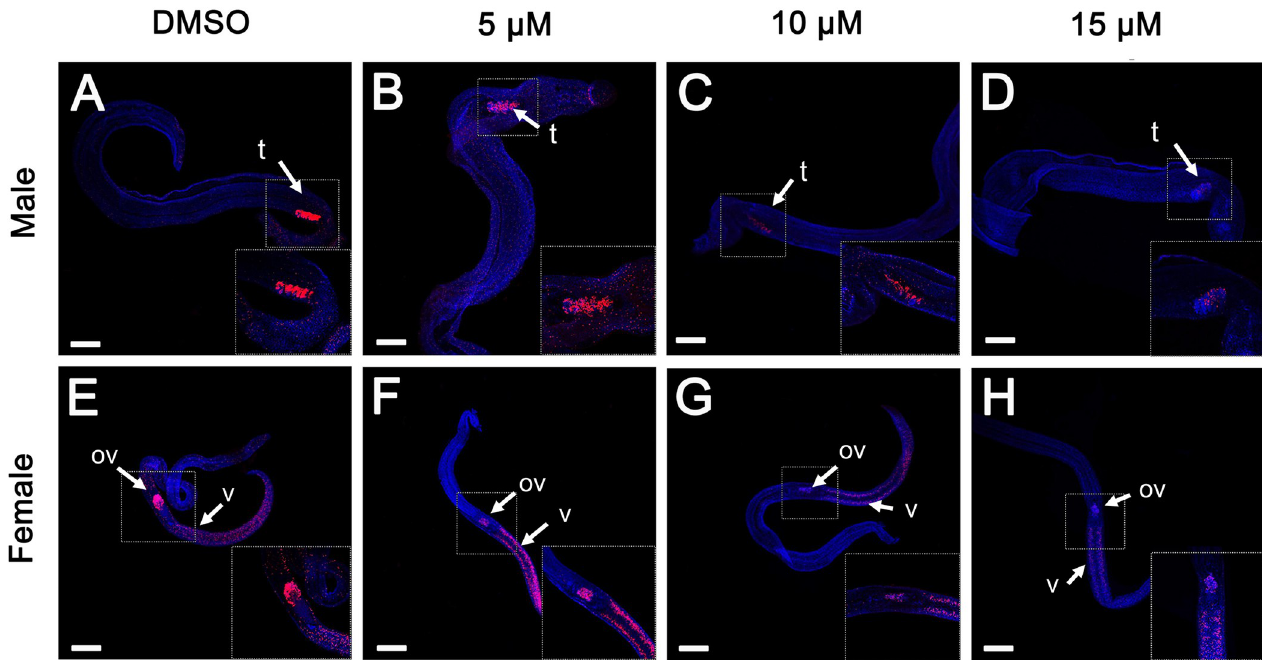
Fig 2. Effect of JQ-1 on cell proliferation in male-female pairs of S . japonicum . Red signals indicate active mitotic cells labeled by EdU; blue signals, Hoechst-positive cells. (A-D) Male S . japonicum and (E-H) female S . japonicum . EdU-incorporated cells are detected in the testes and parenchyma of untreated males (A) and in the vitellarium and ovary of untreated females (E). EdU-positive cells are detected after application of JQ-1 at 5 μ M (B, F), 10 μ M (C, G), and 15 μ M (D, H). Abbreviations: ov, ovary; t, testes; SV, seminal vesicles. Scale bars: 200 μ m.